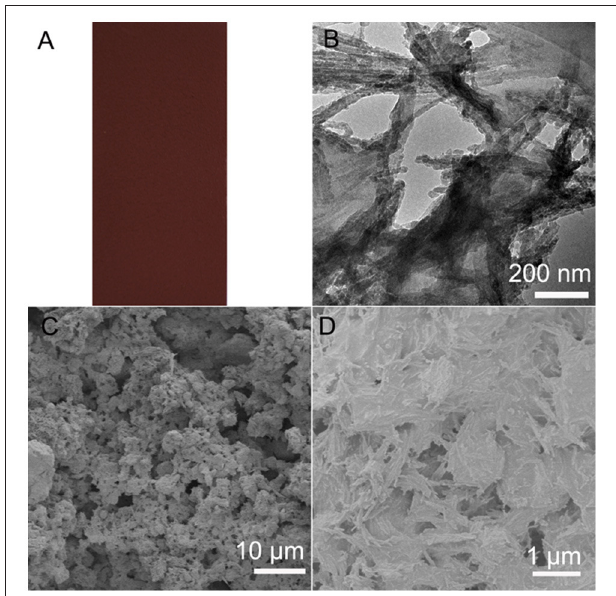
FIGURE 9 | (A ) Digital, (B) TEM (C,D ) SEM images of the PAL/IOR@fluoroPOS coating from hydrothermal reaction of PAL with FeCl 3 · 6H 2 O. C PAL / IOR = 14g L − 1 , C PFDTES = 27.2mM, C TEOS = 4.5mM.